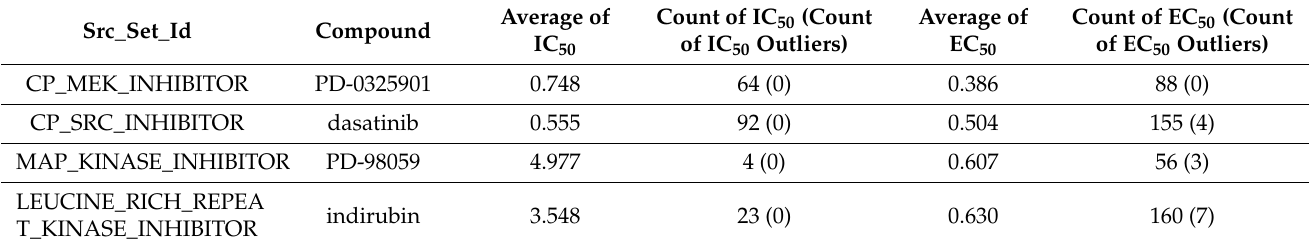
Table 3. Average IC50 and EC50 values of the selected therapeutic compounds in the PRISM dataset. Outliers (drug concentration value > 10) were removed in the calculation of average IC50 and EC50